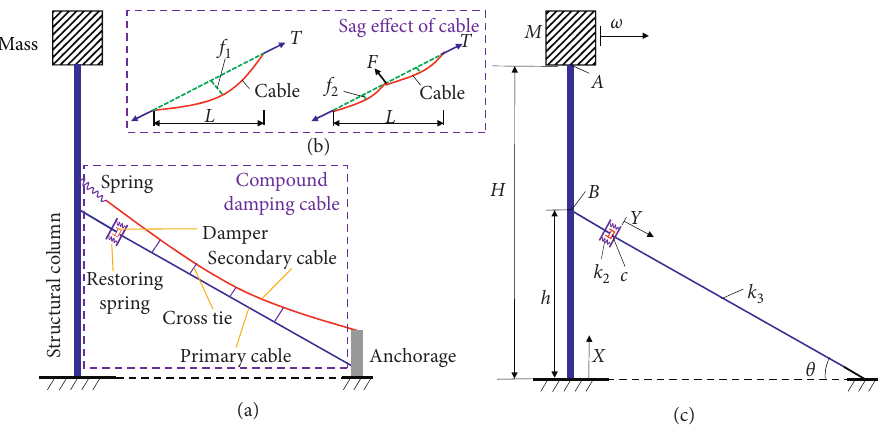
Figure 1: The simple controlled beam structure